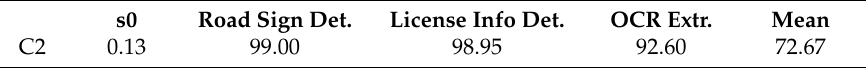
Table 5. Results for the Probabilistic Score on the 4608 × 3072 image pixel resolution. s0 Road Sign Det. License Info